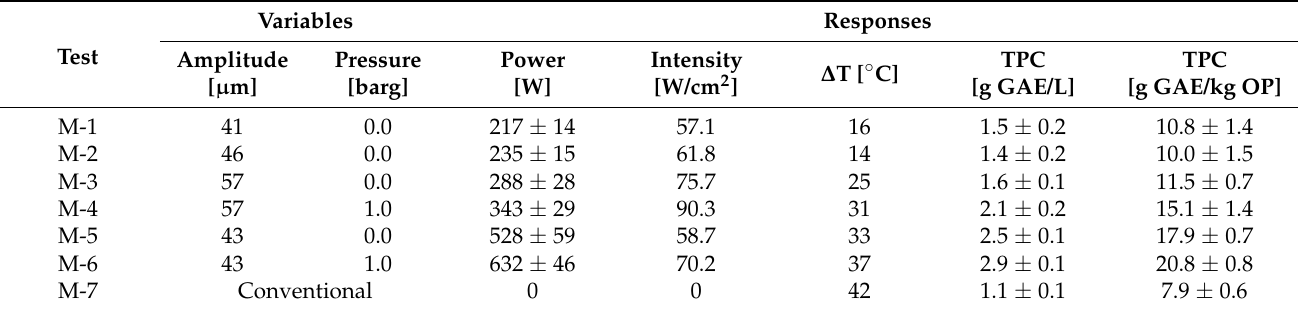
Table 3. Process parameters and responses observed at Medium-scale